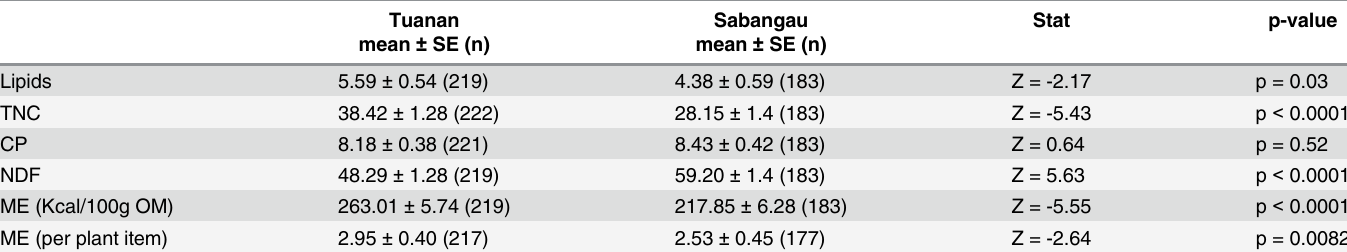
Table 1. Variation in entire sampled diet in Sabangau (S) and Tuanan (T). Wilcoxon Signed Rank Test were used to compare macronutrients and metab- olizable energy (ME) (expressed as % OM) between the two sites. TNC = Total non-structural carbohydrates; CP = Crude Protein; NDF = Neutral Detergent Fiber; ME = metabolizable energy Means and standard errors along with sample size (n) are reported.